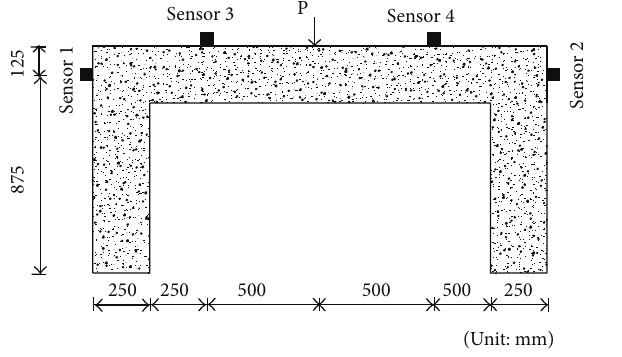
Figure 1: Sensor arrangements for the three-point bending test.